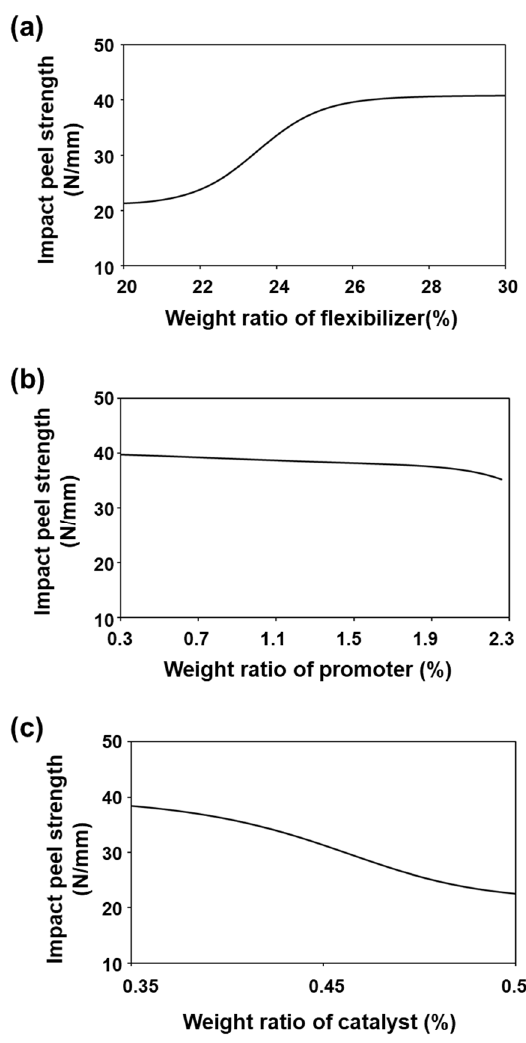
Figure 7. Prediction of impact peel strength by the change in the weight ratio of the ( a ) flexibilizer, ( b ) promoter, and ( c ) catalyst.